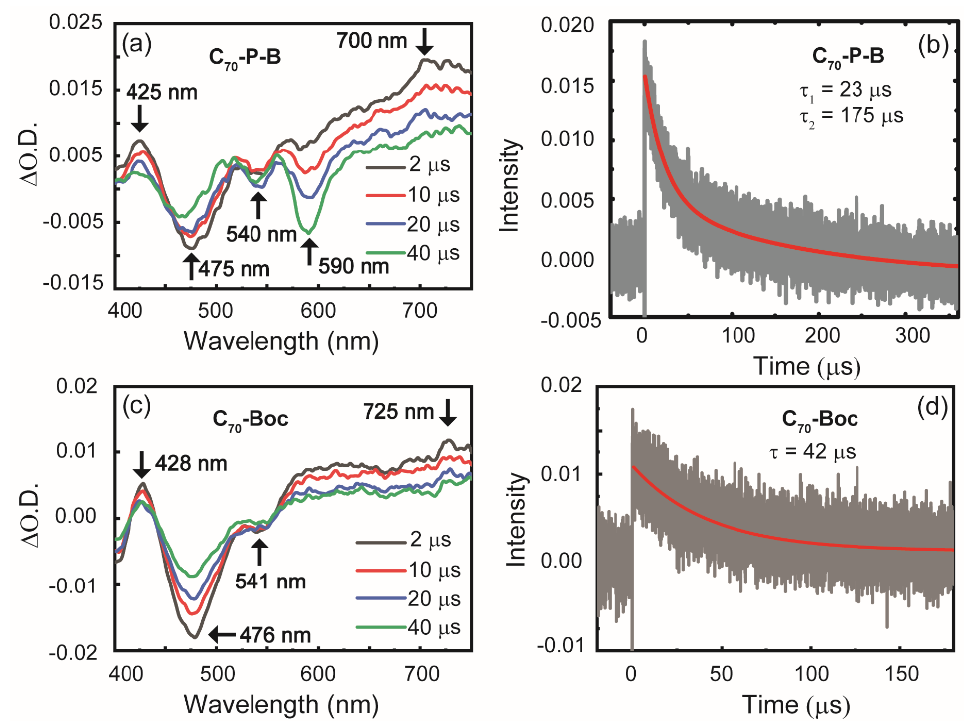
Figure 5. Nanosecond time-resolved transient absorption spectra of ( a ) C 70 -P-B and ( c ) C 70 -Boc upon excitation at 532 nm with a pulse laser (10 ns, 8 mJ/pulse) in deaerated toluene at room temperature. Decay curves of ( b ) C 70 -P-B and ( d ) C 70 -Boc at 700 nm. Arrows indicate the spectral trend with time increasing. The gray lines are the raw data, and the red lines are the fitting curves.